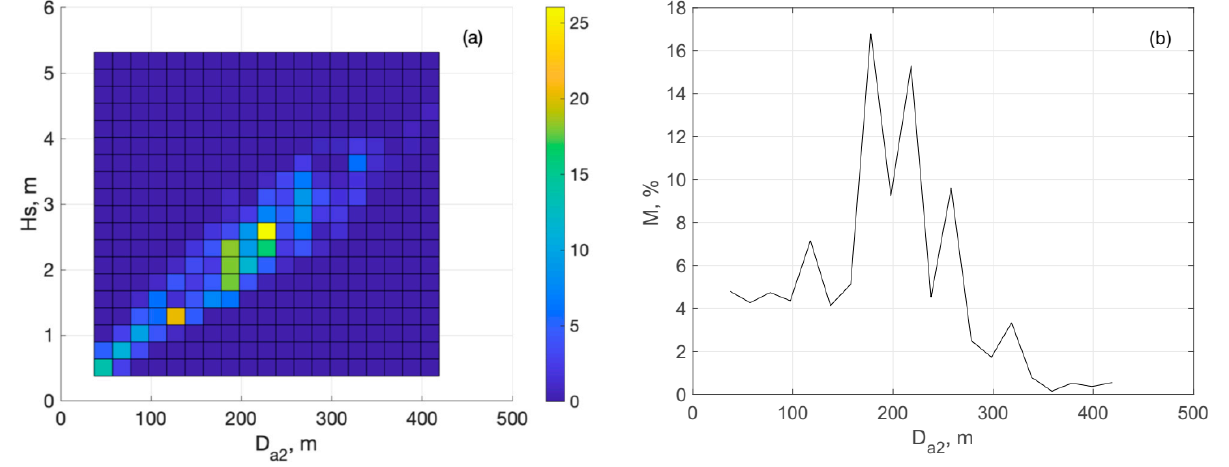
Figure 8. ( a ) Bivariate histogram depending on the value of the second harmonic maximum distance off the shoreline weighted by the dimensionless relation between the significant wave height and the depth of the second harmonic maximum; ( b ) wave impact metric (Equation (6)) dependent on the distance from the second harmonic maximum to the